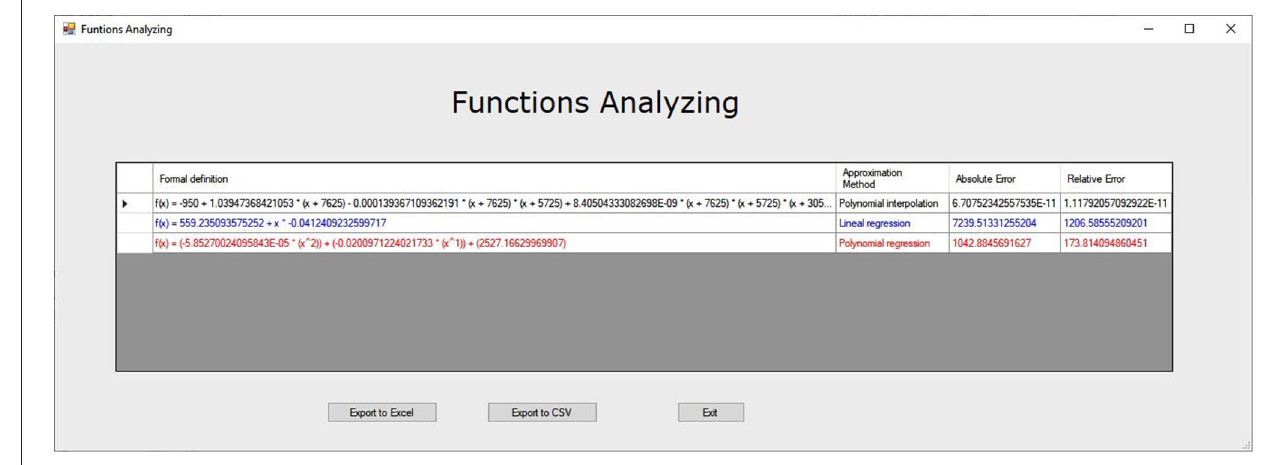
FIGURE 2 | Function